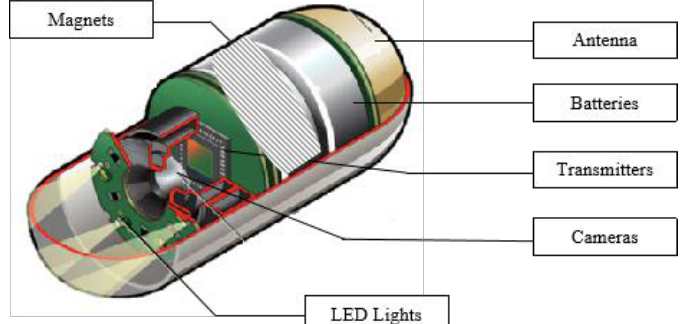
Figure 1. Internal structure of capsule